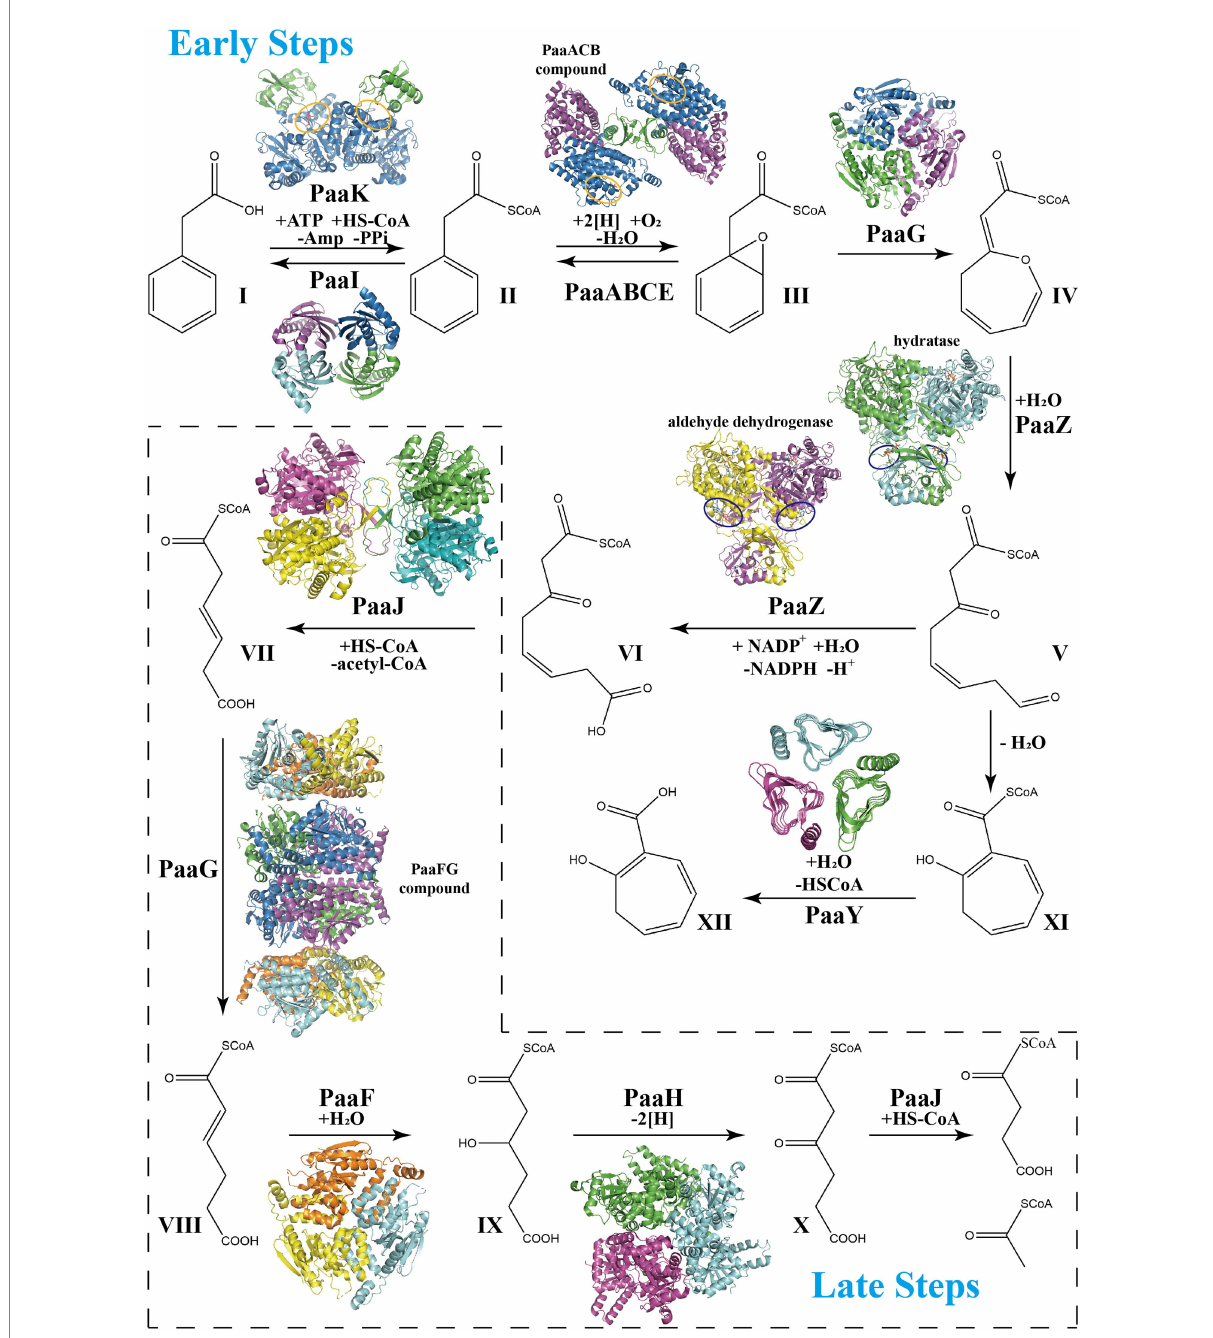
FIGURE 1 Schema of phenylacetate acid degradation pathway. Early PAA pathway: Step 1, Phenylacetate ( I , PA) is converted into phenylacetyl-CoA ( II , PA-CoA), catalyzed by a phenylacetate-CoA ligase PaaK. Thioesterase PaaI could lead this step into a reversible direction when toxic accumulation occurs. Step 2, Epoxidation induced by the monooxygenase complex PaaABCDE in ring 1,2-epoxyphenylacetyl-CoA ( III , ep-CoA). Step 3, PaaG isomerize ep- CoA into 2-oxepin-2(3H)-ylideneacetyl-CoA ( IV , oxepin-CoA), an oxygen-containing heterocycle with three double bonds. Step 4, hydrolysis mediated by the bifunctional enzyme PaaZ induces the oxepin-CoA ring-opening and conversion into 3-oxo-5,6-dehydrosuberyl-CoA semialdehyde ( V ). Compound V spontaneously rearranges to 2-hydroxycyclohepta-1,4,6-triene-1-formyl-CoA ( XI ), which inhibits the enzymatic activity of